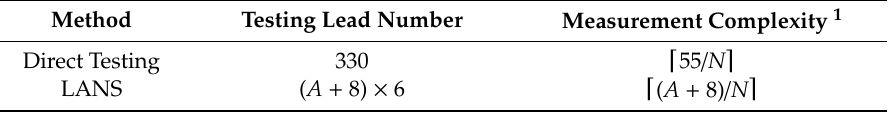
” referred to the ceiling